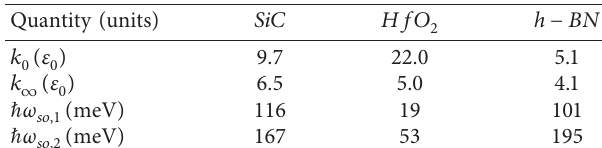
Table 1: Experimental parameters used in the numerical calculations.